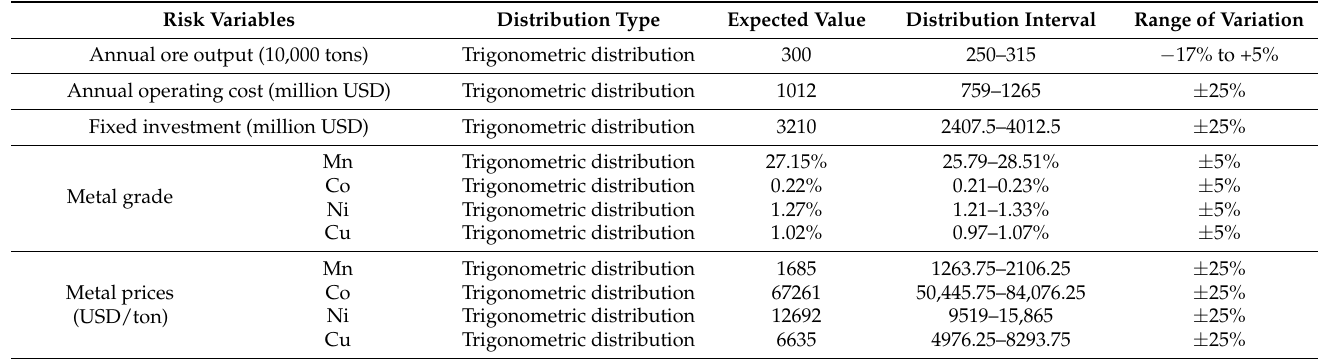
Table 8. Distribution types and distribution intervals of risk variables